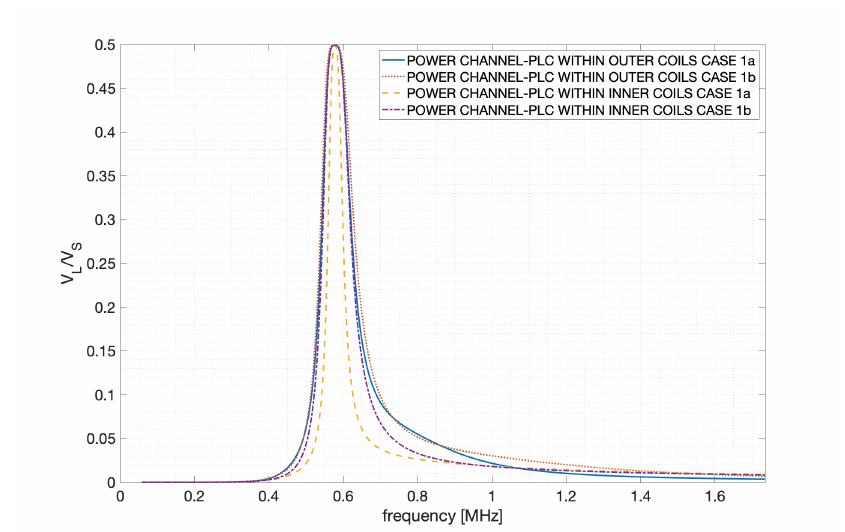
Figure 11. Transfer function comparison for the power channel, Case Study 1.